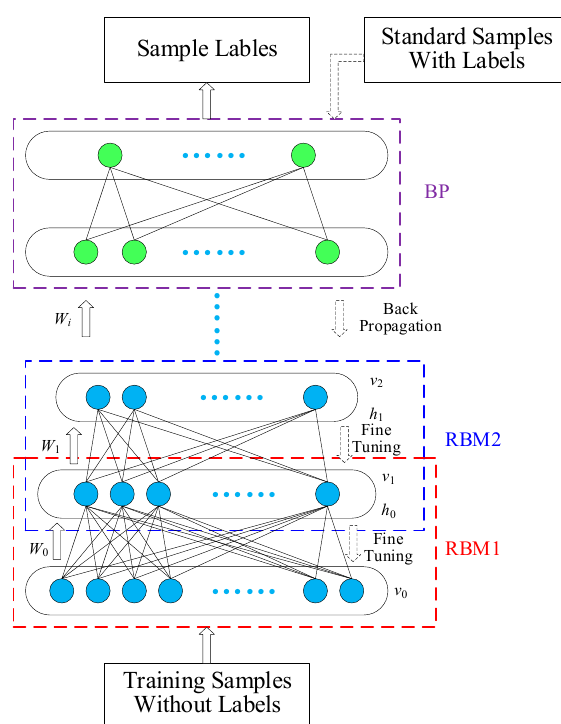
Figure 7. Typical deep belief network (DBN) architecture.